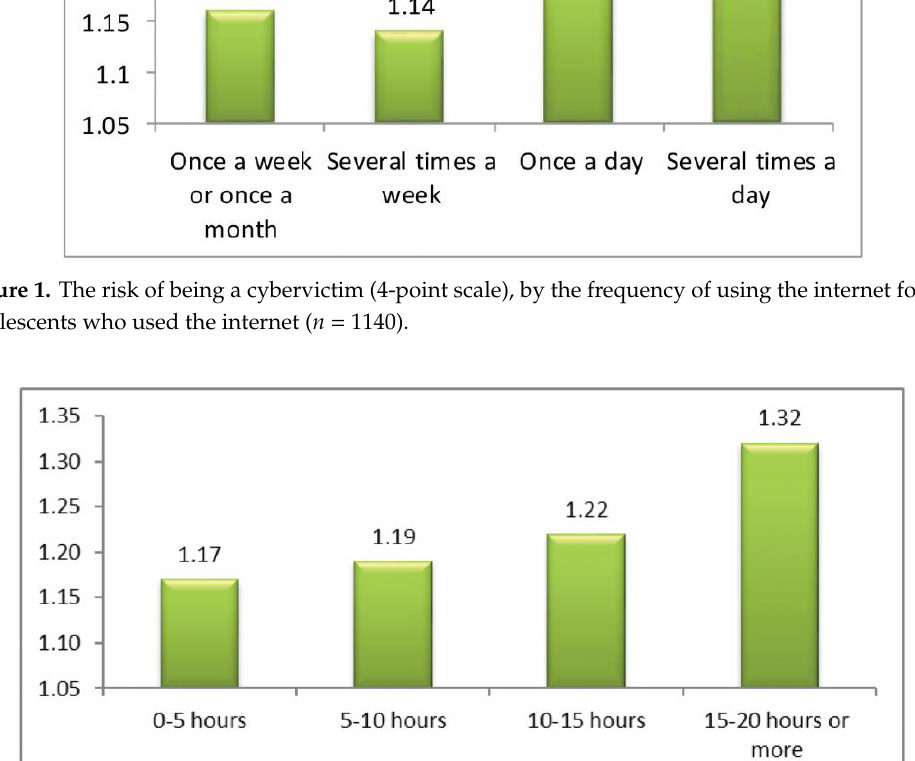
Figure 4. The risk of being a cybervictim (4-point scale), by number of activities on the internet for the adolescents who used the internet ( n = 1140). 2.5. Data Analysis and Statistical Power Data management and analysis were performed by SPSS Version 23 (IBM, Amonk, NY, USA). We measured the relationship between the four measures of internet use and the two measures of cybervictimization. We tested for significance of linear and curvilinear trends with both linear regression and quadratic analysis. We used t -tests to further examine differences between means. We calculated Cohen’s d for effect sizes where appropriate, to indicate the standardized difference between two means. Przybylski and Weinstein [16] found that the average effect size (Cohen’s d ) for engagement in excess of the inflection points was −0.18. Regarding statistical power for our study, with an alpha error of 5% and a power of 80%, we would need an n of 394 to detect statistically significant differences with d = 0.20, and an n of 1571 at d = 0.10. Our full sample of 1140 is therefore satisfactory, although our subsample of 163 is under-powered. 3. Results 3.1. Internet Use We found that adolescents often used the internet to do homework or assignments from schools, and commonly used it to download songs, movies, and programs, to play games, to send and receive emails, to chat, to surf the internet, to use other social media such as MSN or Yahoo, and to use Skype